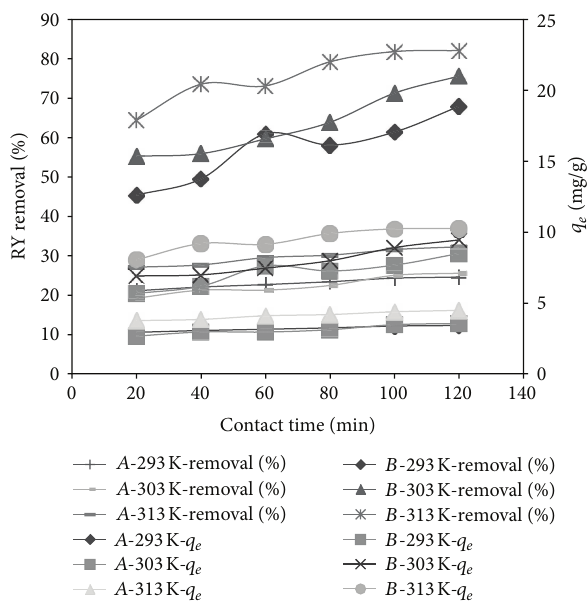
Figure 6: The temperature and contact time effects on dye removal efficiency and adsorption capacity of SSCAC for Remazol Yellow adsorption (adsorbent dosage: 𝐴 = 0.1 g/50mL and 𝐵 = 0.4 g/ 50 mL, initial dye concentration: 100mg/L, pH: 2).